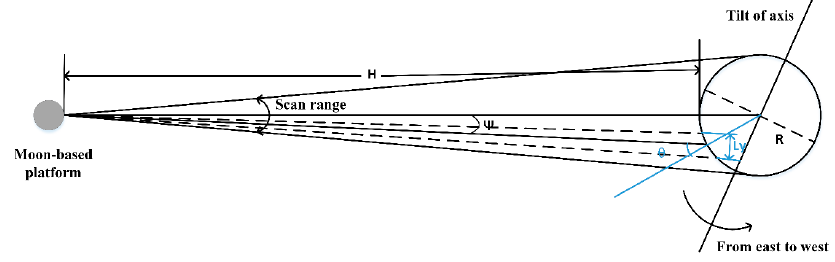
Figure 1. The microwave radiometer imaging principle from the Moon-based Earth observation (MEO) platform.